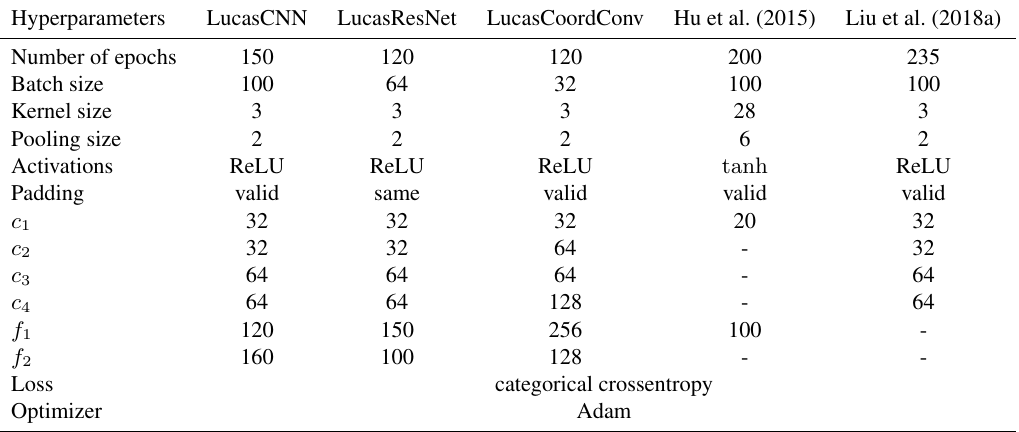
Table 1. Hyperparameters of the new 1D CNN approaches LucasCNN, LucasResNet and LucasCoordConv as well as the existing CNN approaches by Hu et al. (2015) and Liu et al. (2018a). The number of filters in the i -th CONV layer is defined as c i and the number of units in the i -th FC layer is defined as f j .